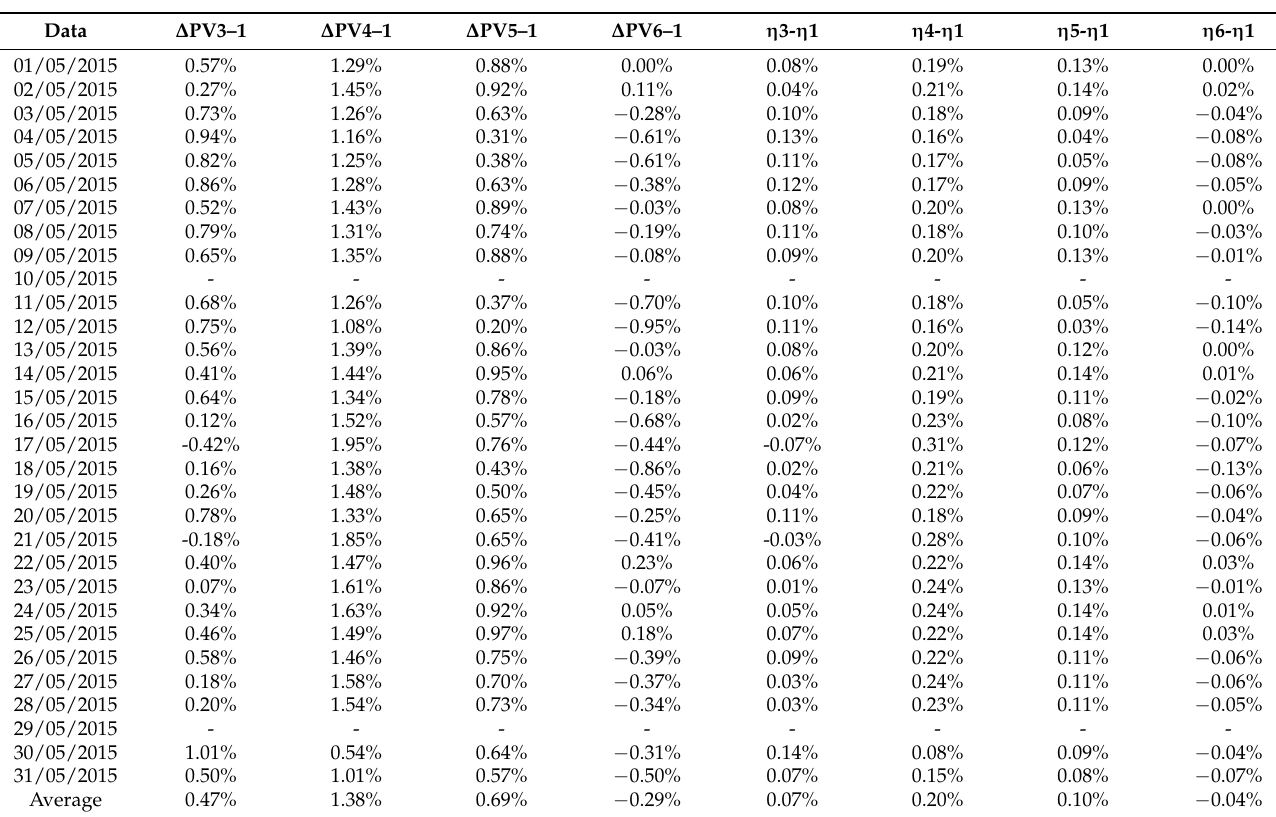
Table 3. Percentage difference in daily electric energy produced by the analyzed module with reference to PV1 and absolute daily average efficiency difference with module